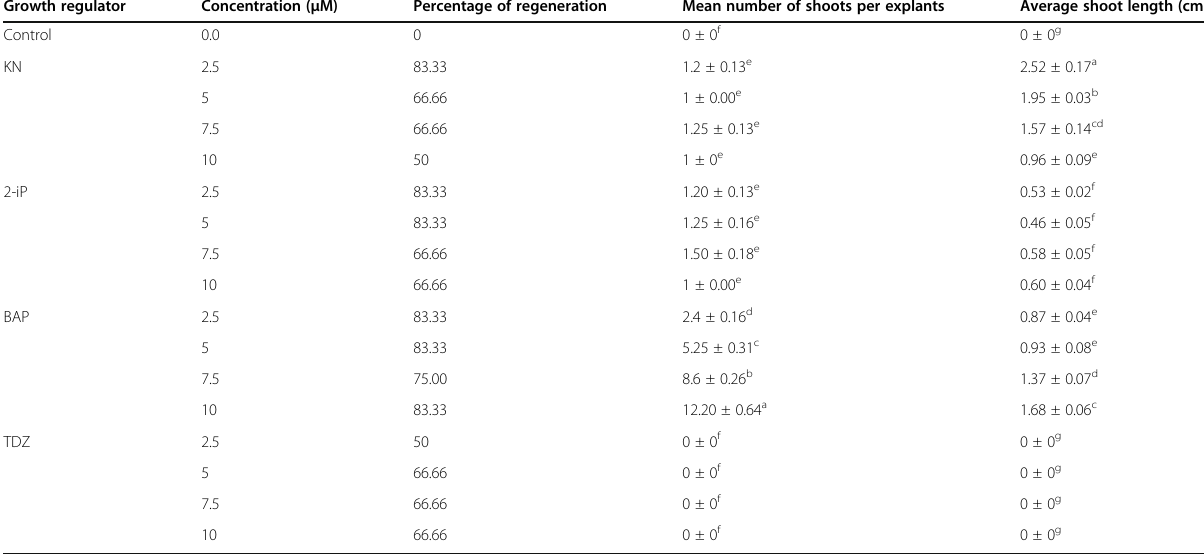
Table 1 Response of nodal explants of Andrographis alata cultured on MS medium supplemented with cytokinins Growth regulator